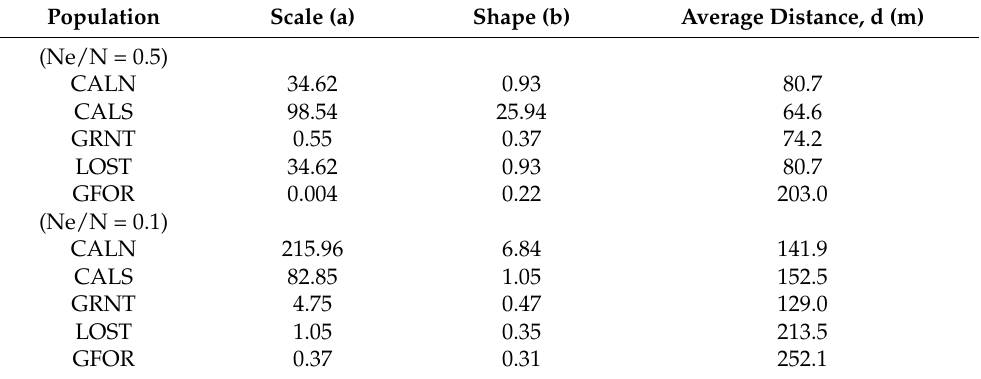
Table 3. Pollen dispersal parameters obtained using the TwoGener